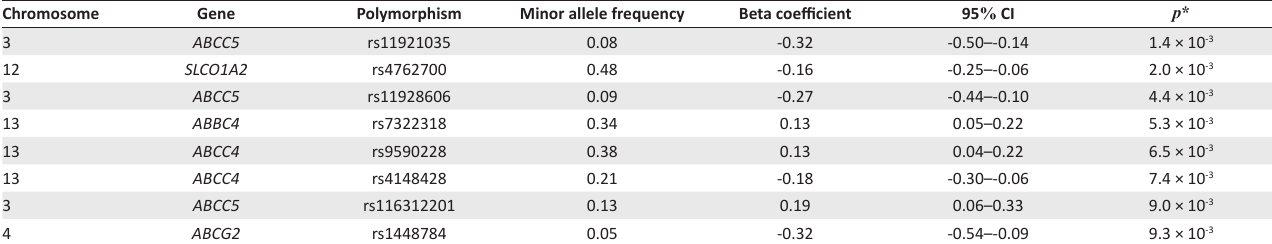
-transformed cerebrospinal fluid -to plasma emtricitabine concentrations in 39 South African adults. 10